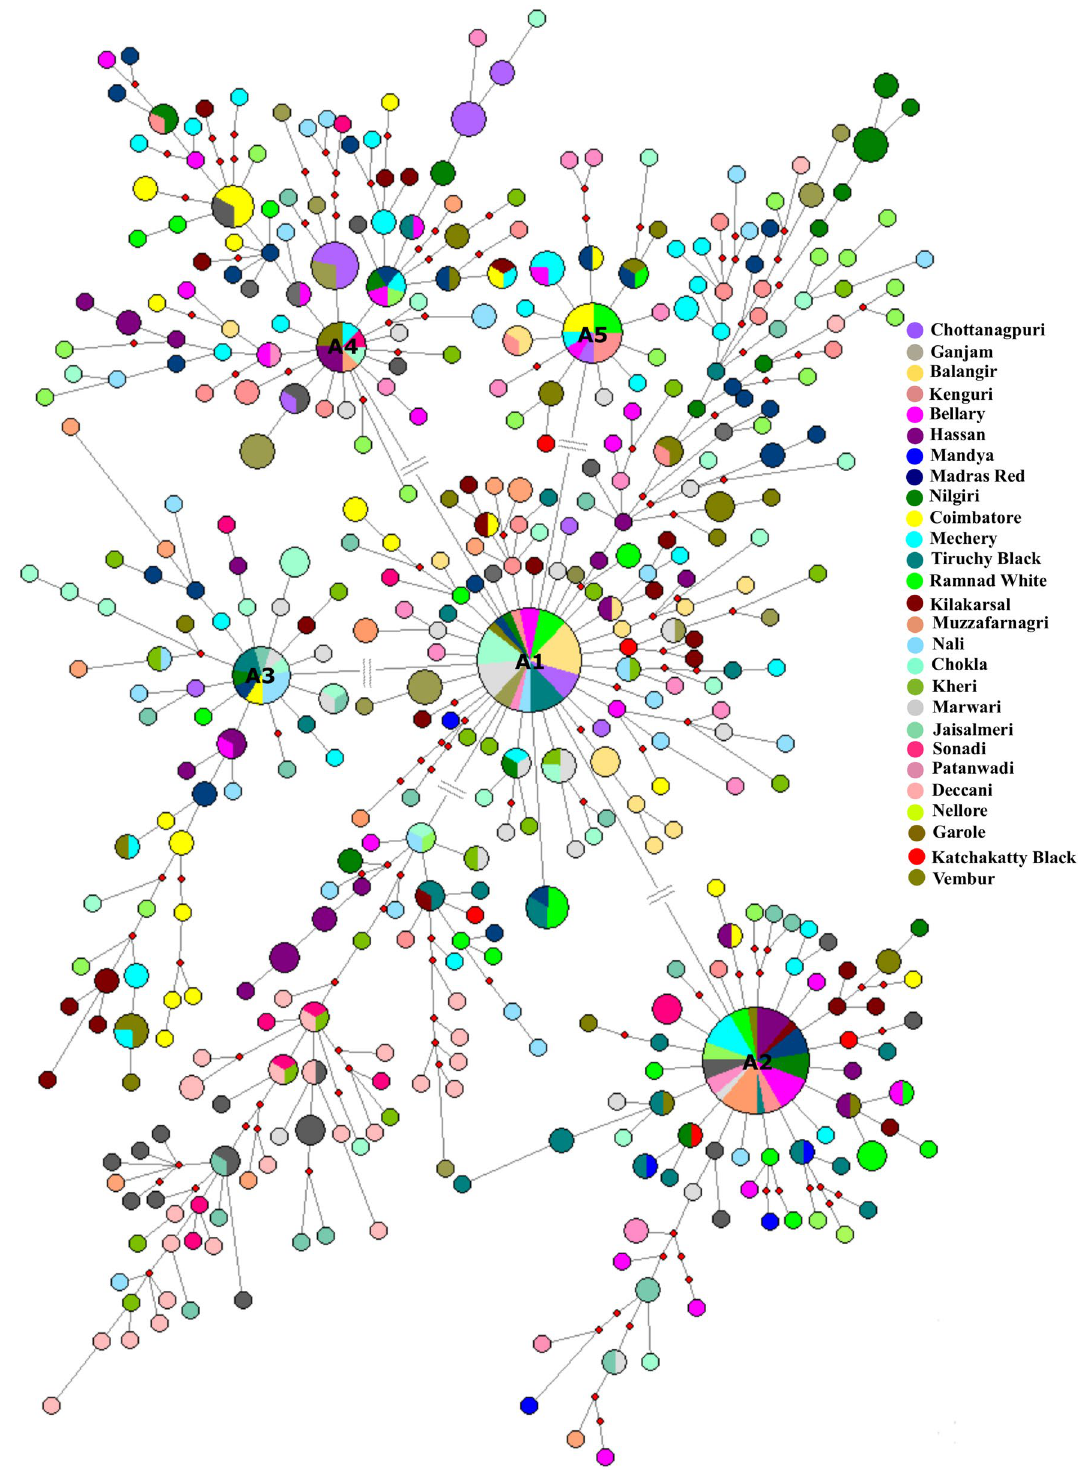
Figure 5. Median-joining network of Indian domestic sheep lineage A. The MJ network was constructed using 655 D-loop sequences (612 bp) belonging to 27 Indian sheep breeds. Size of the node is proportional to the number of sheep present in the node. The length of the line is proportional to the number of mutations (# indicates that the length of the line is not proportional to the number of mutations. There is only one mutation between the two haplotypes but length of the line has been adjusted for the convenient arrangement of the node). Sheep breeds are indicated by different colours. The small red rectangles represent the median vector. The network was constructed using Network 10.2.0.0 17 and edited in Inkscape 1.0 (https:// inksc ape.